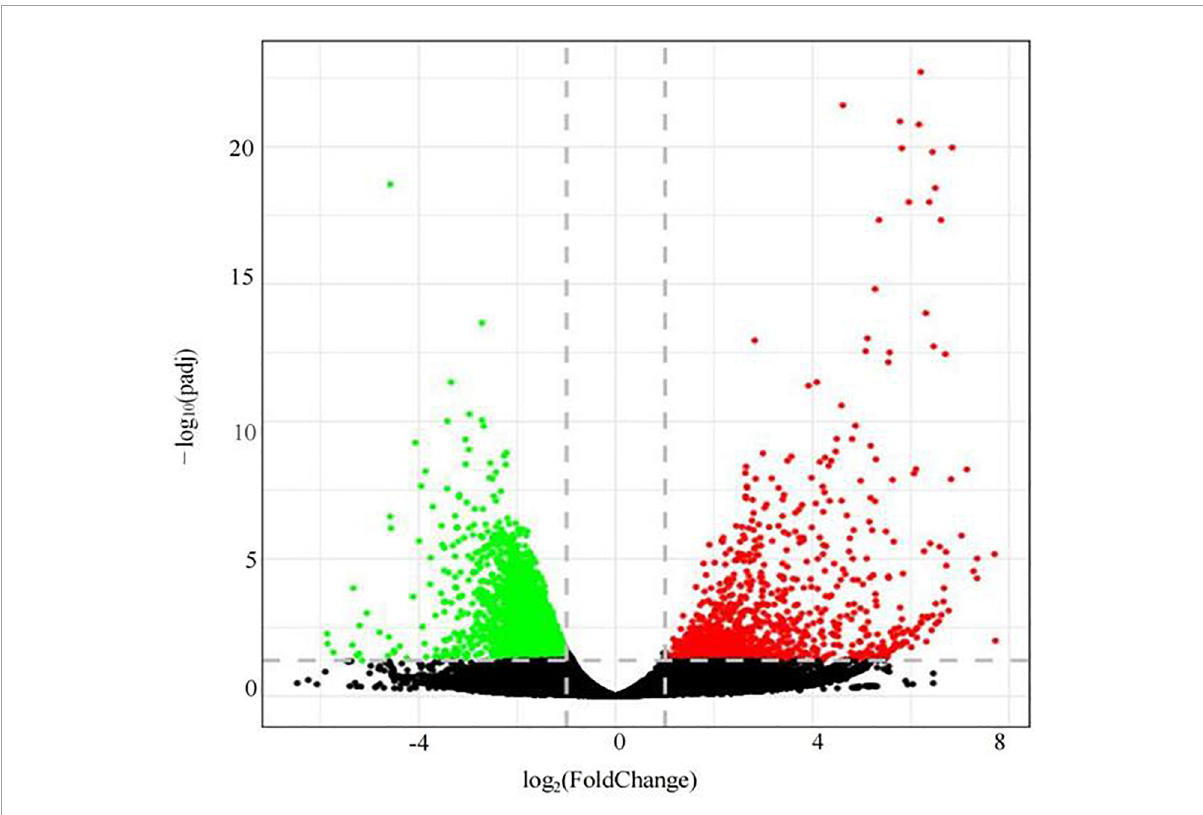
FIGURE4 Differential gene volcano